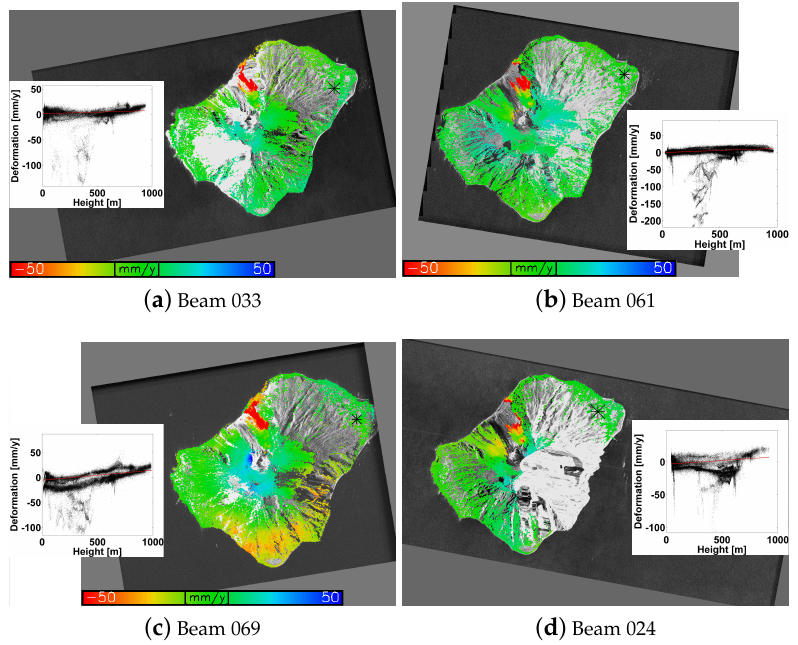
Figure 8. PS deformation maps after mitigation of the differential tropospheric delay for the stacks